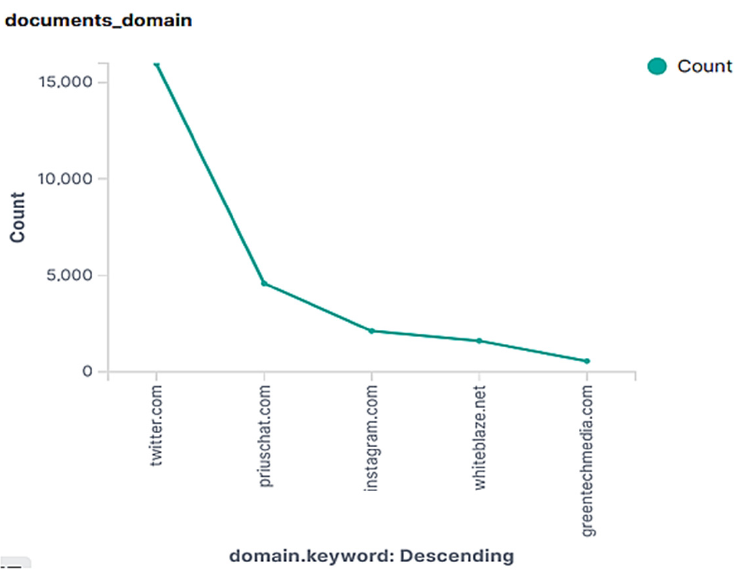
Figure 7. Main distribution of sources at technology analysis (storage systems)